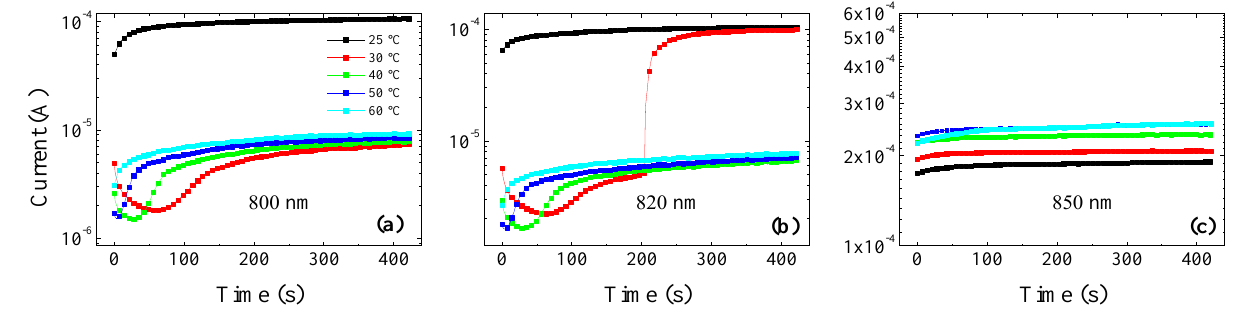
Figure 11. Current transients at different temperatures under cathode irradiation: ( a ) 800 nm; ( b ) 820 nm; ( c ) 850 nm. Applied voltage is 600